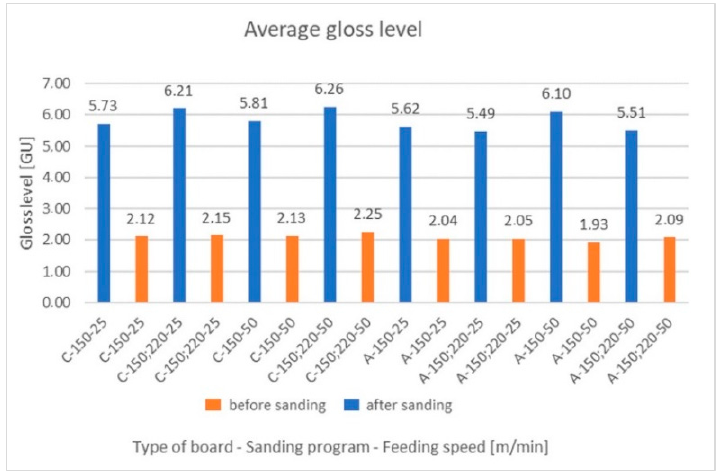
Figure 8. Average gloss level before and after sanding board A and